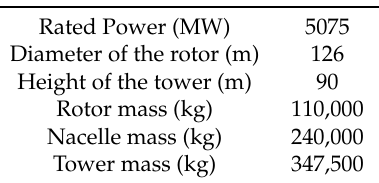
Figure 6. Illustration of the ( a ) single offshore wind turbine and ( b ) offshore wind farm of Case 2. Table 6. Offshore wind turbine characteristics.